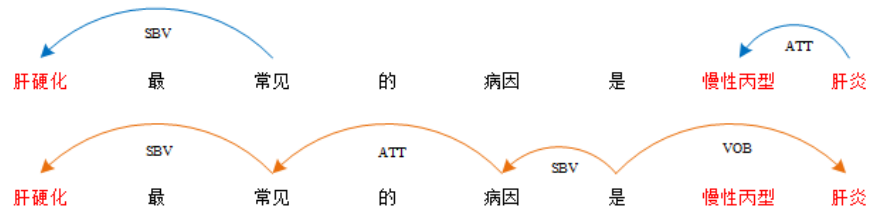
Figure 4. Two pruning operation diagrams: top is local subtree pruning; bottom is shortest-path tree pruning. SBV, subject–predicate relation; ATT, definitive–medial relation; VOB, verb-object relation. The Chinese sentence in the figure means “The most common cause of liver cirrhosis is chronic hepatitis C”. “ 肝 硬 化 ” represents “liver cirrhosis”, “ 最 ” represents “the most”, “ 常 见 ” represents “common”, “ 的 ” represents “of”, “ 病 因 ” represents “cause”, “ 是 ” represents “is”, “ 慢 性 丙 型 ” represents “chronic C”, “ 肝 炎 ” represents “hepatitis”.